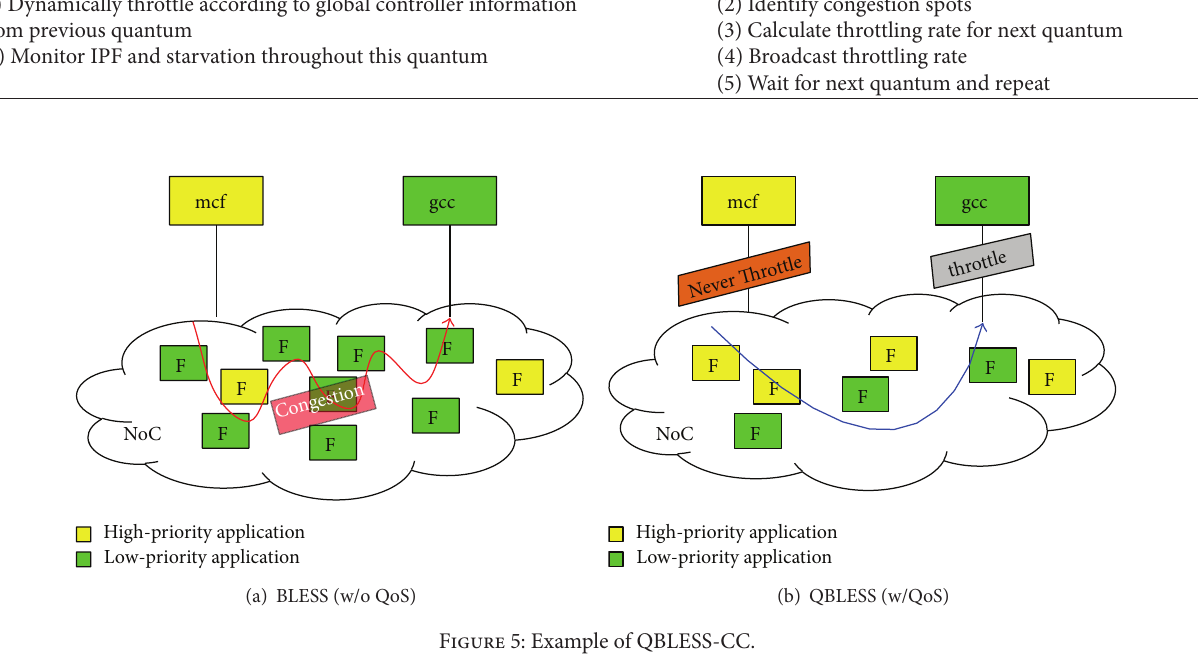
Figure 5: Example of